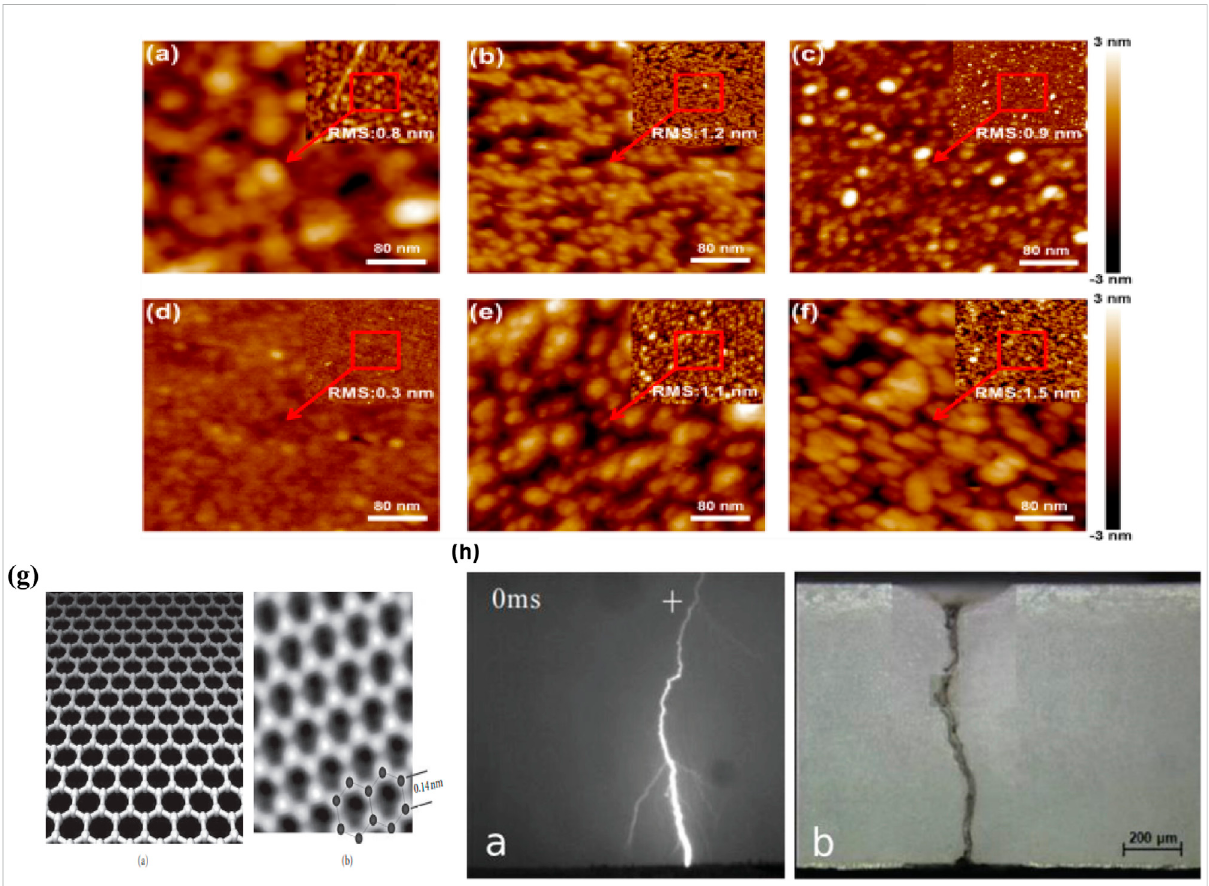
FIGURE 1 AFM images of Al ₂ O ₃ /Gr after ALD cycles, each cycle with pre-H ₂ O treatment at 100 ° C is shown. (A) One, (B) two, (C) three, (D) four, (E) fi ve, (F) six cycles [34], (G) structure of graphene and the high-resolution transmission electron microscopic (HRTEM) picture is shown [15], and (H) a cloud- to-earth electrical discharge through the air is shown and an Al 2 O 3 fi lm subjected to high electric fi eld stress is also shown